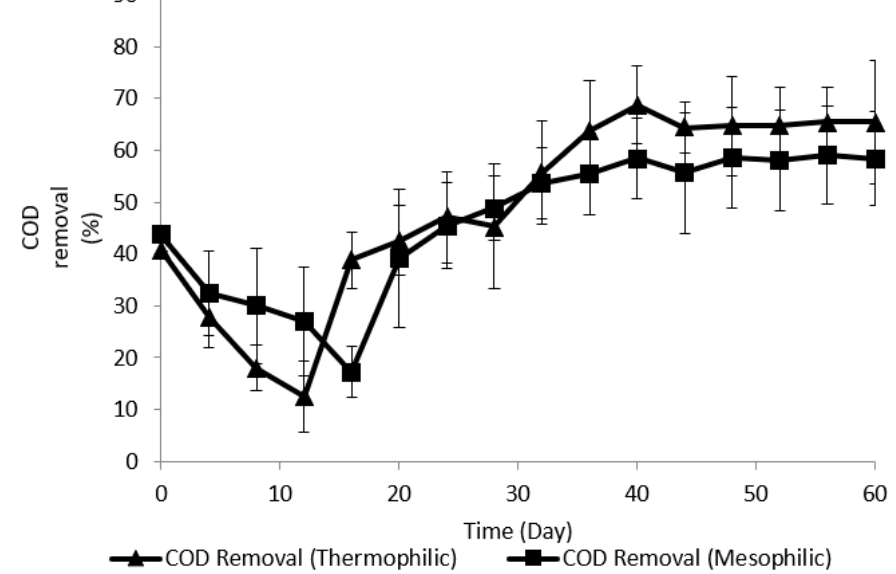
Figure 3. The range of COD removal for thermophilic and mesophilic e ffl uents during the acclimatization period. Notes: error bars show standard deviation of means (n =